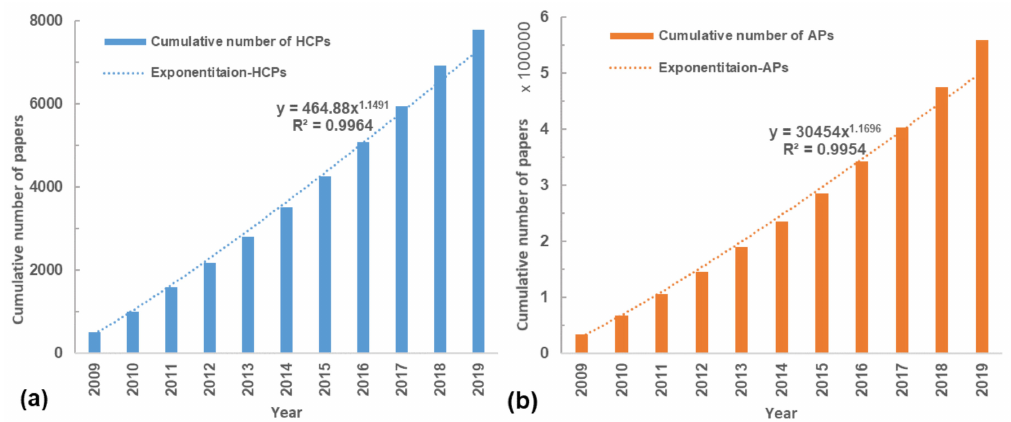
Figure 2. Cumulative number of (a) highly cited papers (HCPs) and (b) all papers (APs) in the environmental sciences